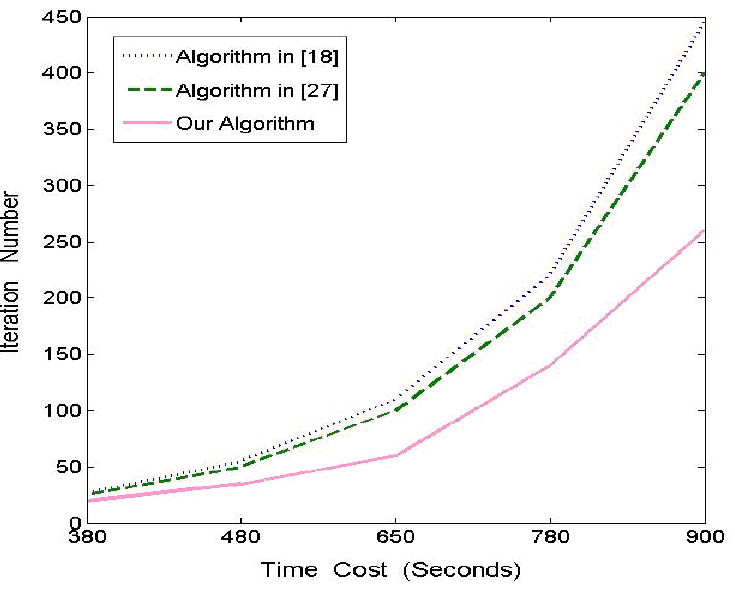
Figure 6. Numerical comparison between three